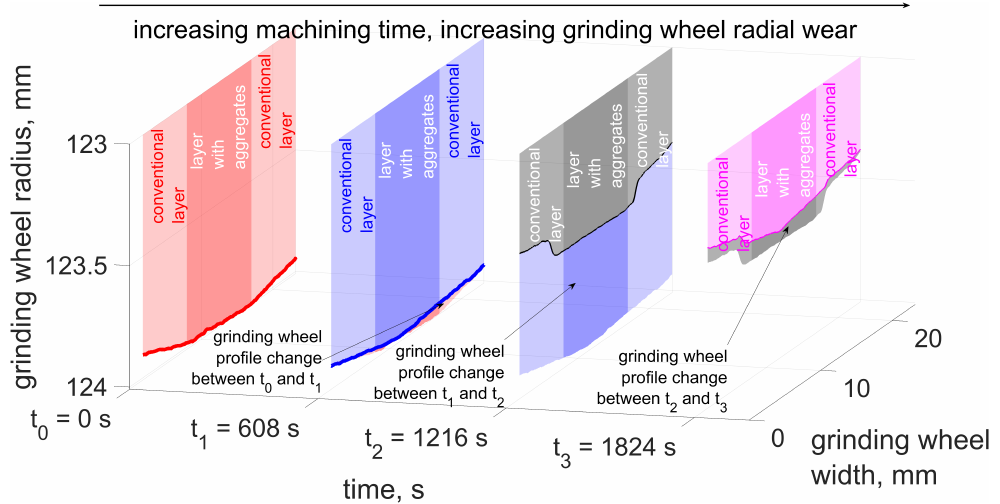
Figure 6. Change in radial wear of the grinding wheel during